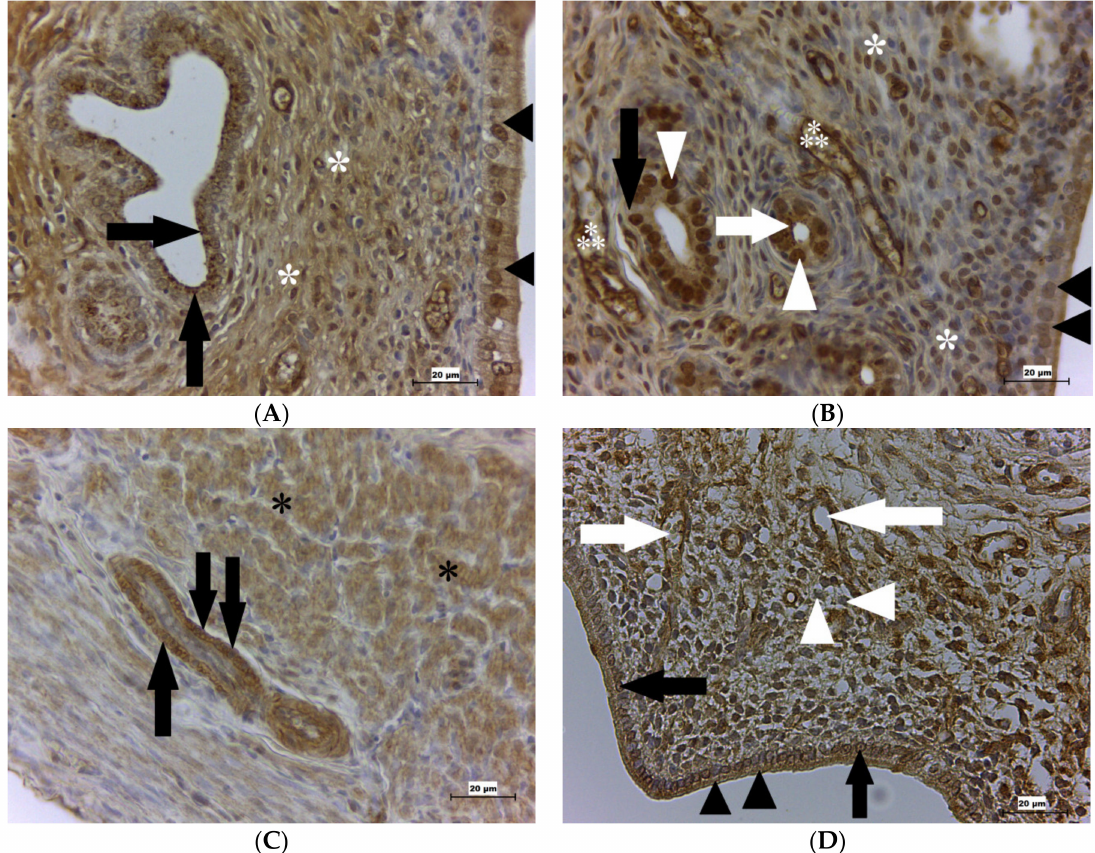
Figure 4. GPx4 presence in the rat uterus. ( A ) Shows the rat uterus on D1. Immunohistochemical analysis shows the GPx4 positivity of the endometrium, namely, granules inside the uterine glands (arrows) mostly in the apical part of the cells, stroma (asterisks), cytoplasm, and the nuclei (arrowheads) of the luminal epithelial cells. ( B ) Shows the rat uterus on D1. Immunohistochemical analysis of the endometrium shows GPx4 positivity of granules in the uterine gland epithelium (white arrow) mostly in the apical part of the cells, the nuclei (white arrowheads) and cytoplasm (black arrow) of the cells, in the blood vessels ( ), stroma (asterisks), and luminal epithelial cells (black arrowheads). ( C ) Shows the rat uterus on D1. Immunohistochemical analysis shows the positivity of GPx4 in the smooth muscle cells in the myometrium (asterisks) and blood vessels (arrows). ( D ) Shows the rat uterus on D5. Immunohistochemical analysis of GPx4 shows the positivity of the cytoplasm (black arrowheads) and the nuclei (black arrows) of the epithelial cells, stellate-like fibroblasts (white arrowheads) of the endometrium, and blood vessels (white arrows). Scale bar = 20 µ m. GPx4 is glutathione peroxidase 4; D1 is the first day of pregnancy; D5 is the fifth day of